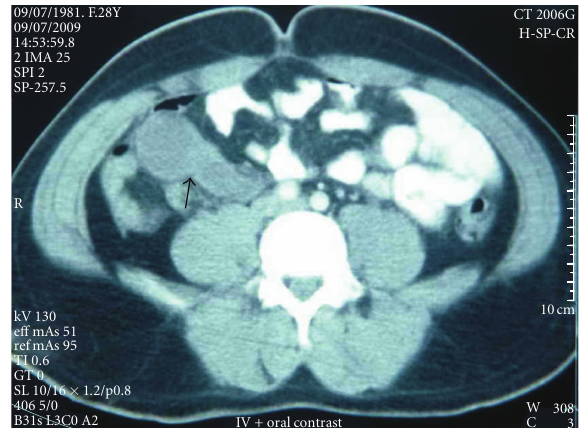
Figure 1: Lobulated cystic mass with slightly enhancing smooth walls in the right lower peritoneal cavity adjacent to the small bowel loops. None of the orally administered opaque material was in the cystic cavity.